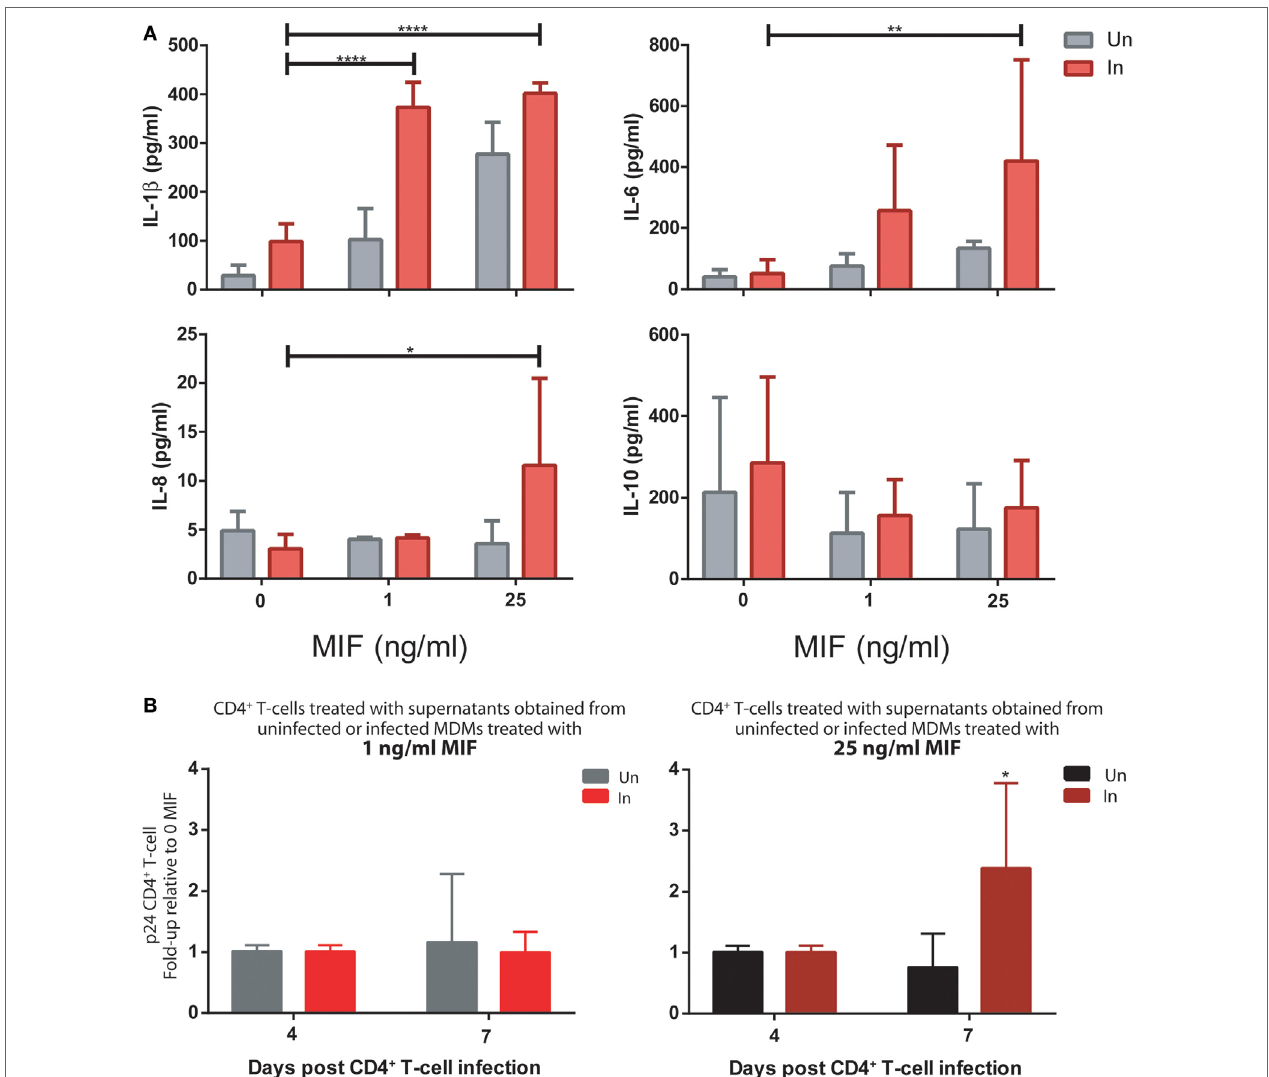
FigUre 8 | Infection of monocyte-derived macrophages (MDMs) and unactivated CD4 + T-cells with T/F viruses reproduce the results obtained with the R5-tropic (BAL) and the X4-tropic (NL4-3) laboratory strains. (a) Expression of IL-1 β , IL-8, IL-6, and IL-10 in supernatants from uninfected (Un) and R5-tropic T/F-infected (In) MDMs. Data represent mean ± SD from three independent donors. Data were analyzed by two-way ANOVA followed by Tukey’s post-test. * p < 0.05, ** p < 0.01, **** p < 0.0001. (B) Human immunodeficiency virus (HIV) p24 antigen production from primary unactivated CD4 + T-cells incubated with supernatants from uninfected and infected MDMs treated with 1 ng/ml (left panel) or 25 ng/ml (right panel) macrophage migration inhibitory factor (MIF). Treated CD4 + T-cells were infected with a dual-tropic T/F virus and viral production was evaluated at 4 and 7 days post-infection. Data represent mean ± SD from five independent donors. Data were analyzed by two-way ANOVA followed by Sidak’s post-test. * p <